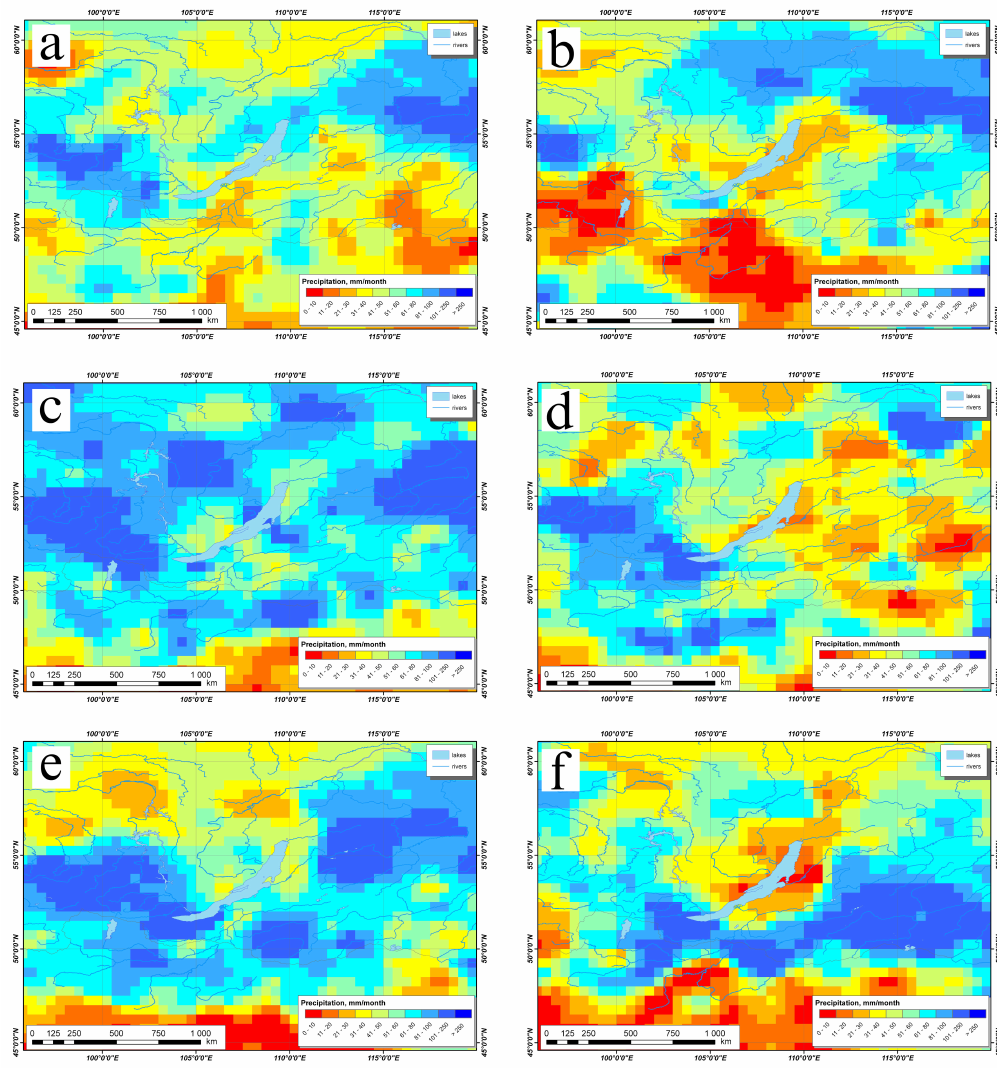
Figure 8. The comparison between the spatial distribution of Global Precipitation Climatology Center (GPCC), Version 2018 climatic precipitation dataset monthly precipitation (mm / month) in the relative wet 2010 summer ( a , c , e ) and in the abnormally dry 2015 summer ( b , d , f ) is shown. Panels ( a,b ) correspond to June, ( c , d ) correspond to July, and ( e , f ) correspond to